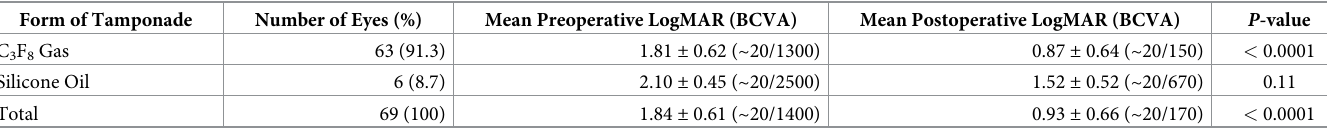
Table 4. Visual outcomes based on tamponade agent.